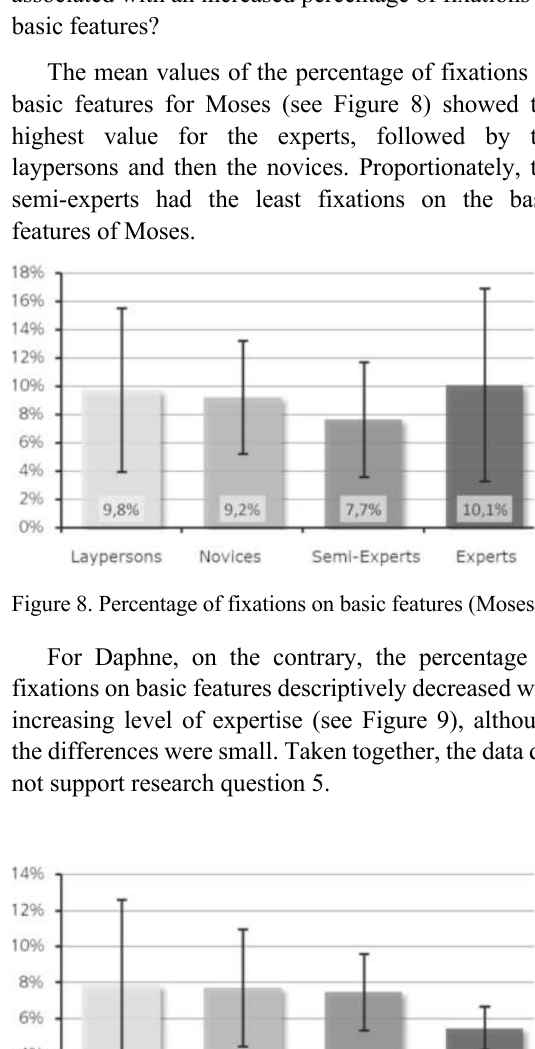
Table 9. Mean values and standard deviations of the distances with different divergence of the expertise level.